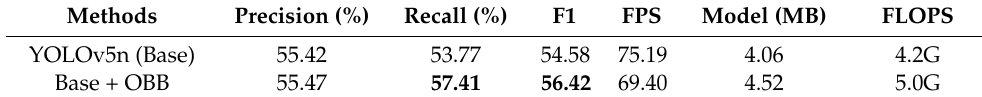
Table 5. Performance comparison of different attention modules with OBB prediction method.